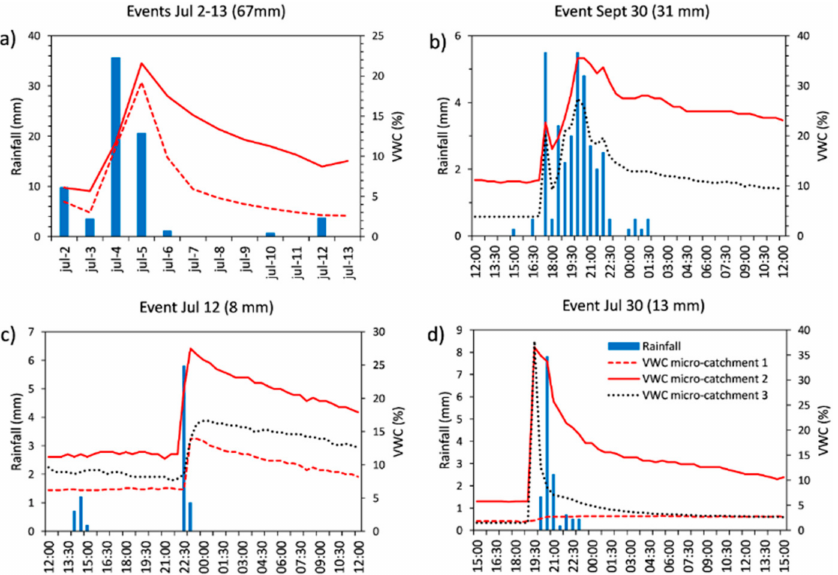
Figure 9. Soil moisture behavior after thinning of three micro-catchments with different magnitudes of rainfall events: ( a ) series of rainfall events in July 2019; ( b ) large rainfall event; ( c , d ) small rainfall events.